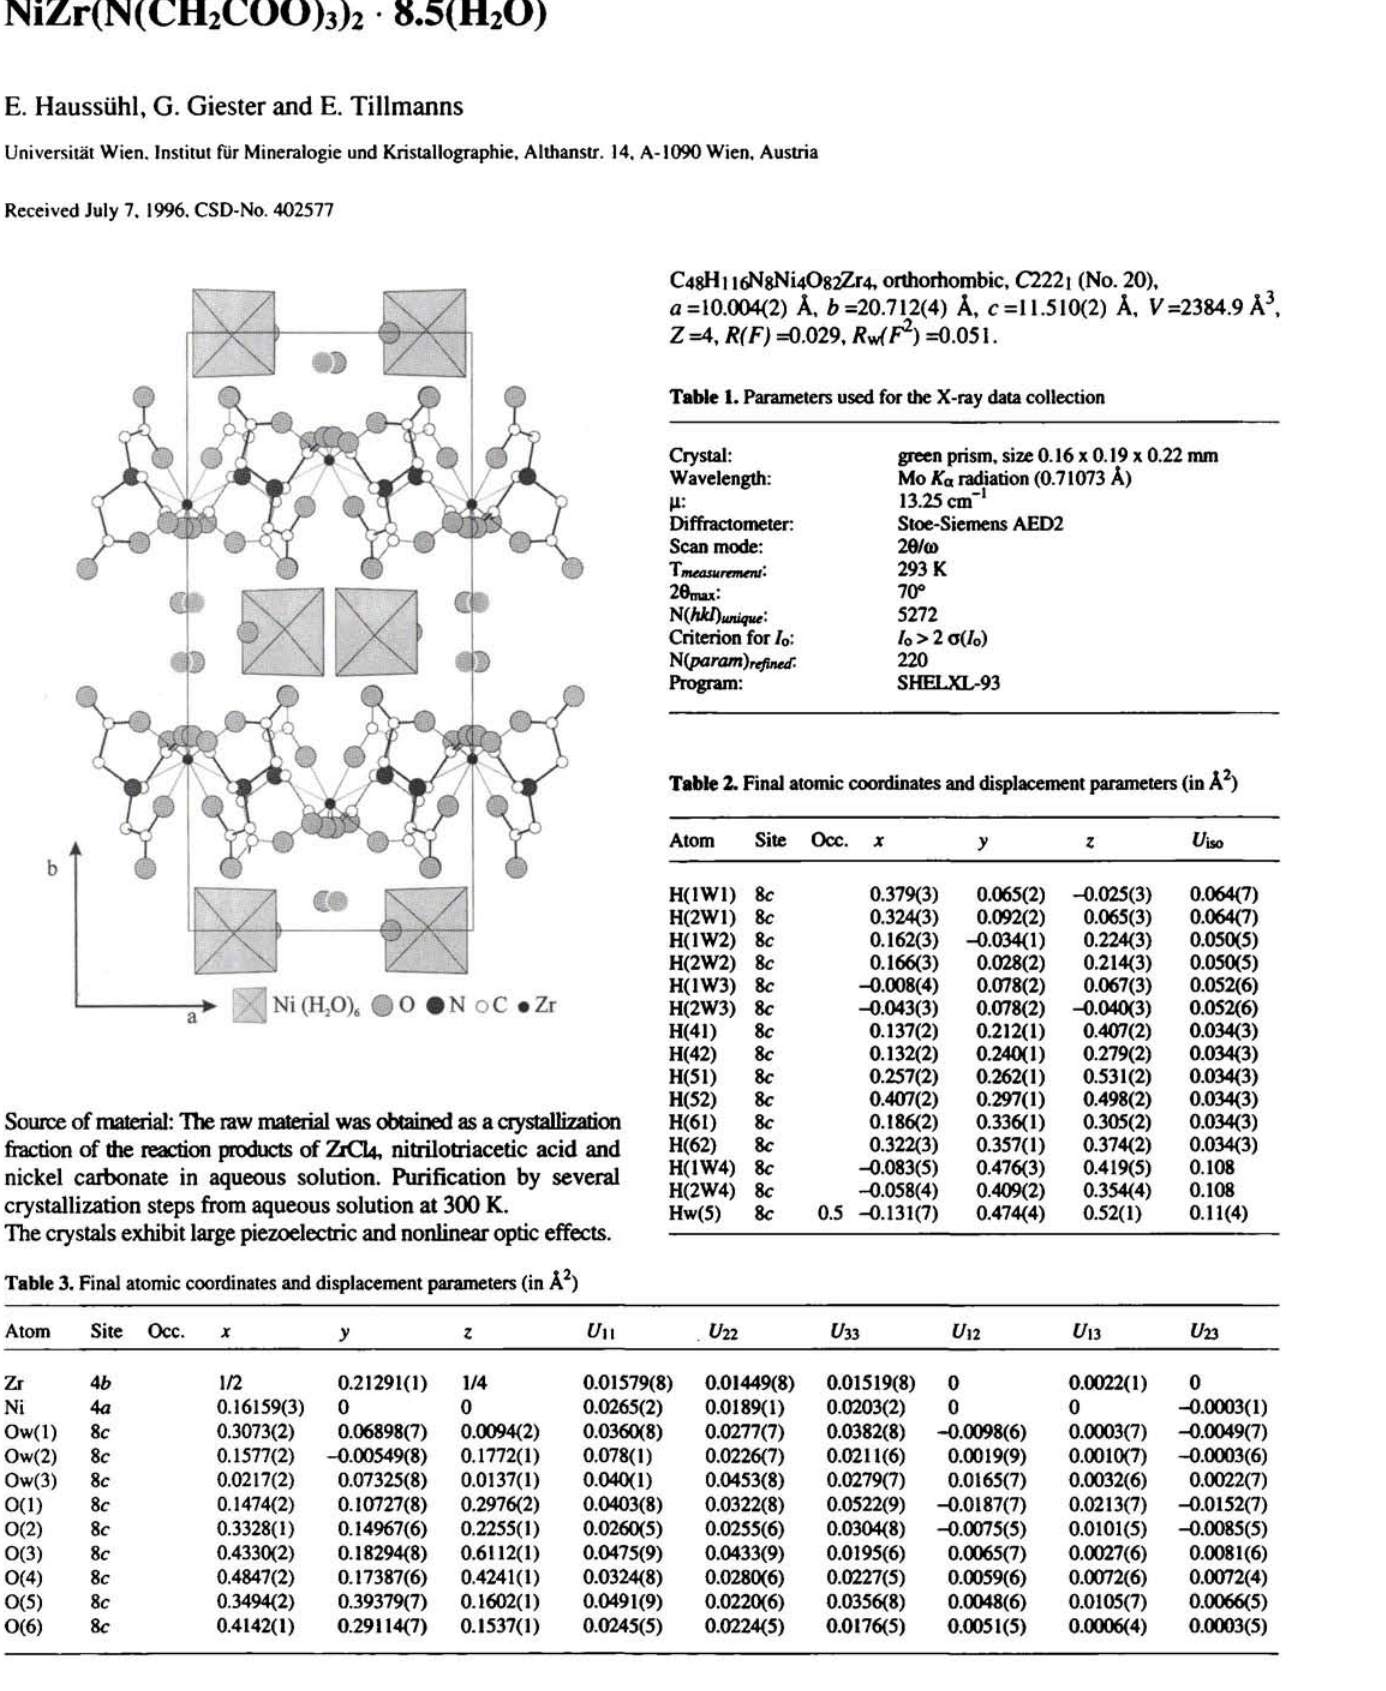
Table 1. Parameters used for the X-ray data collection Crystal: